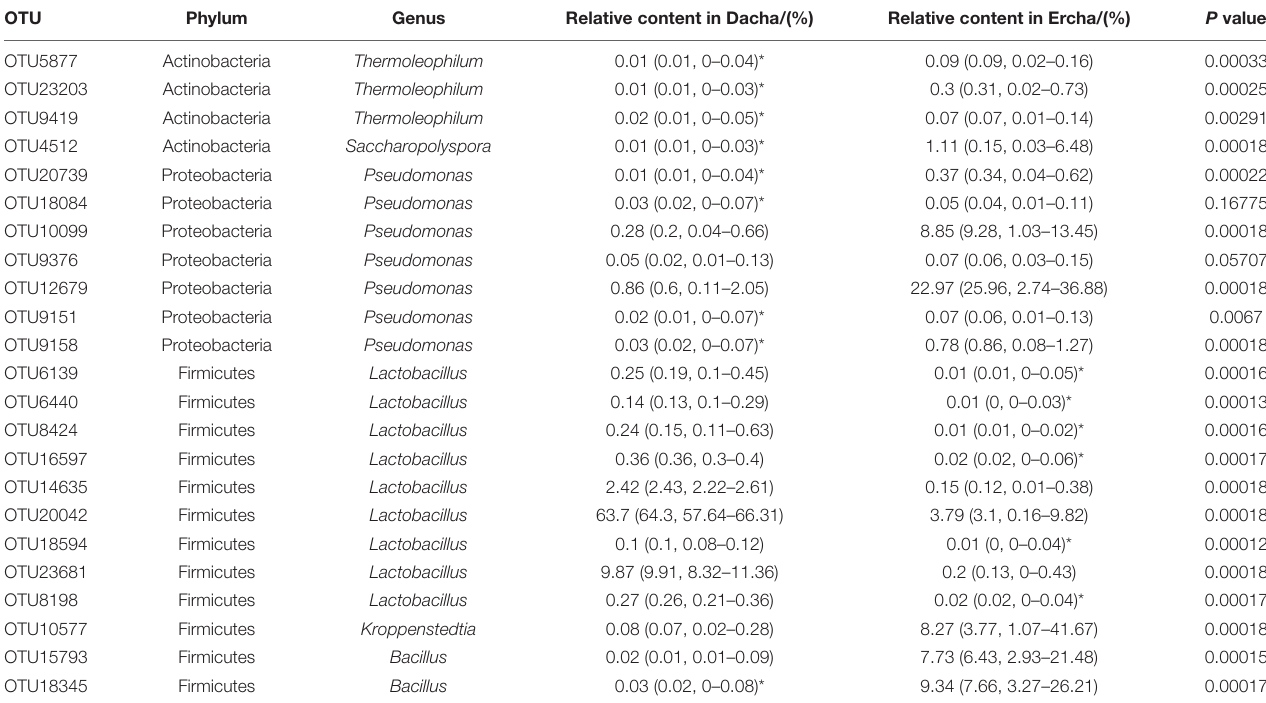
TABLE 2 | Information on the bacterial phylum and genus of core OTUs.